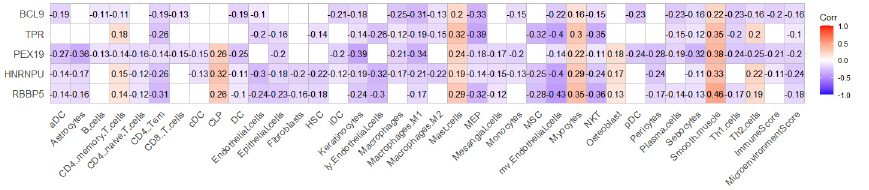
Figure 5. A heat map of the correlation between hub genes and immune cells. It can be seen that these five genes are closely related to the abundance of most immune cells.